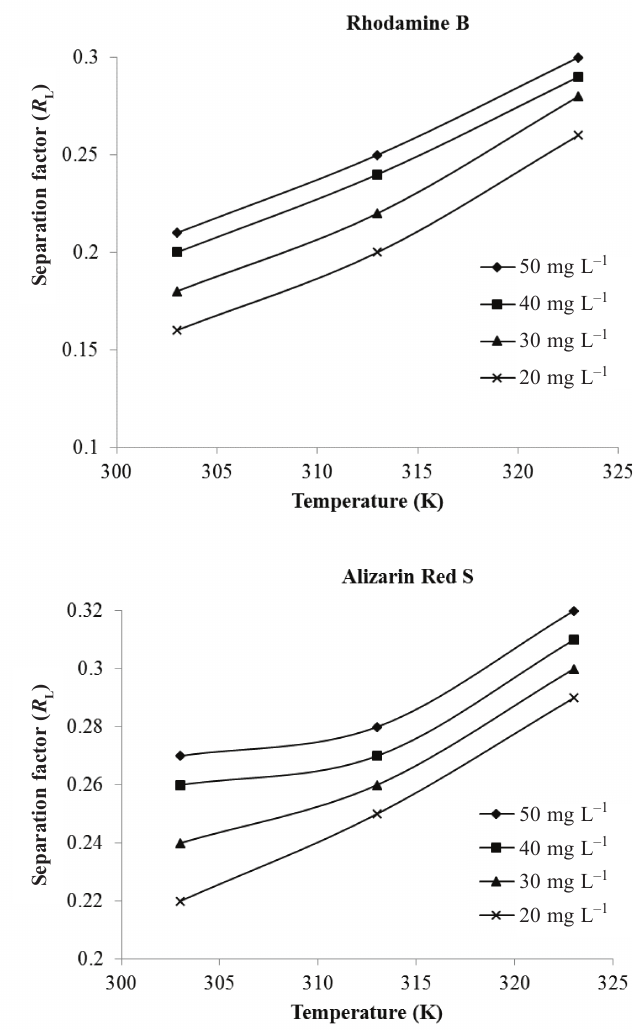
Fig. 11 – Effect of dye concentration and temperature on separation factor